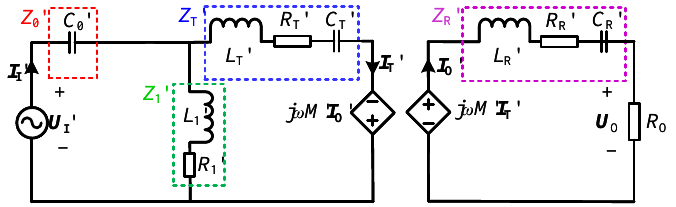
Figure 8. Equivalent circuit diagram of the CLC/S compensated WPT